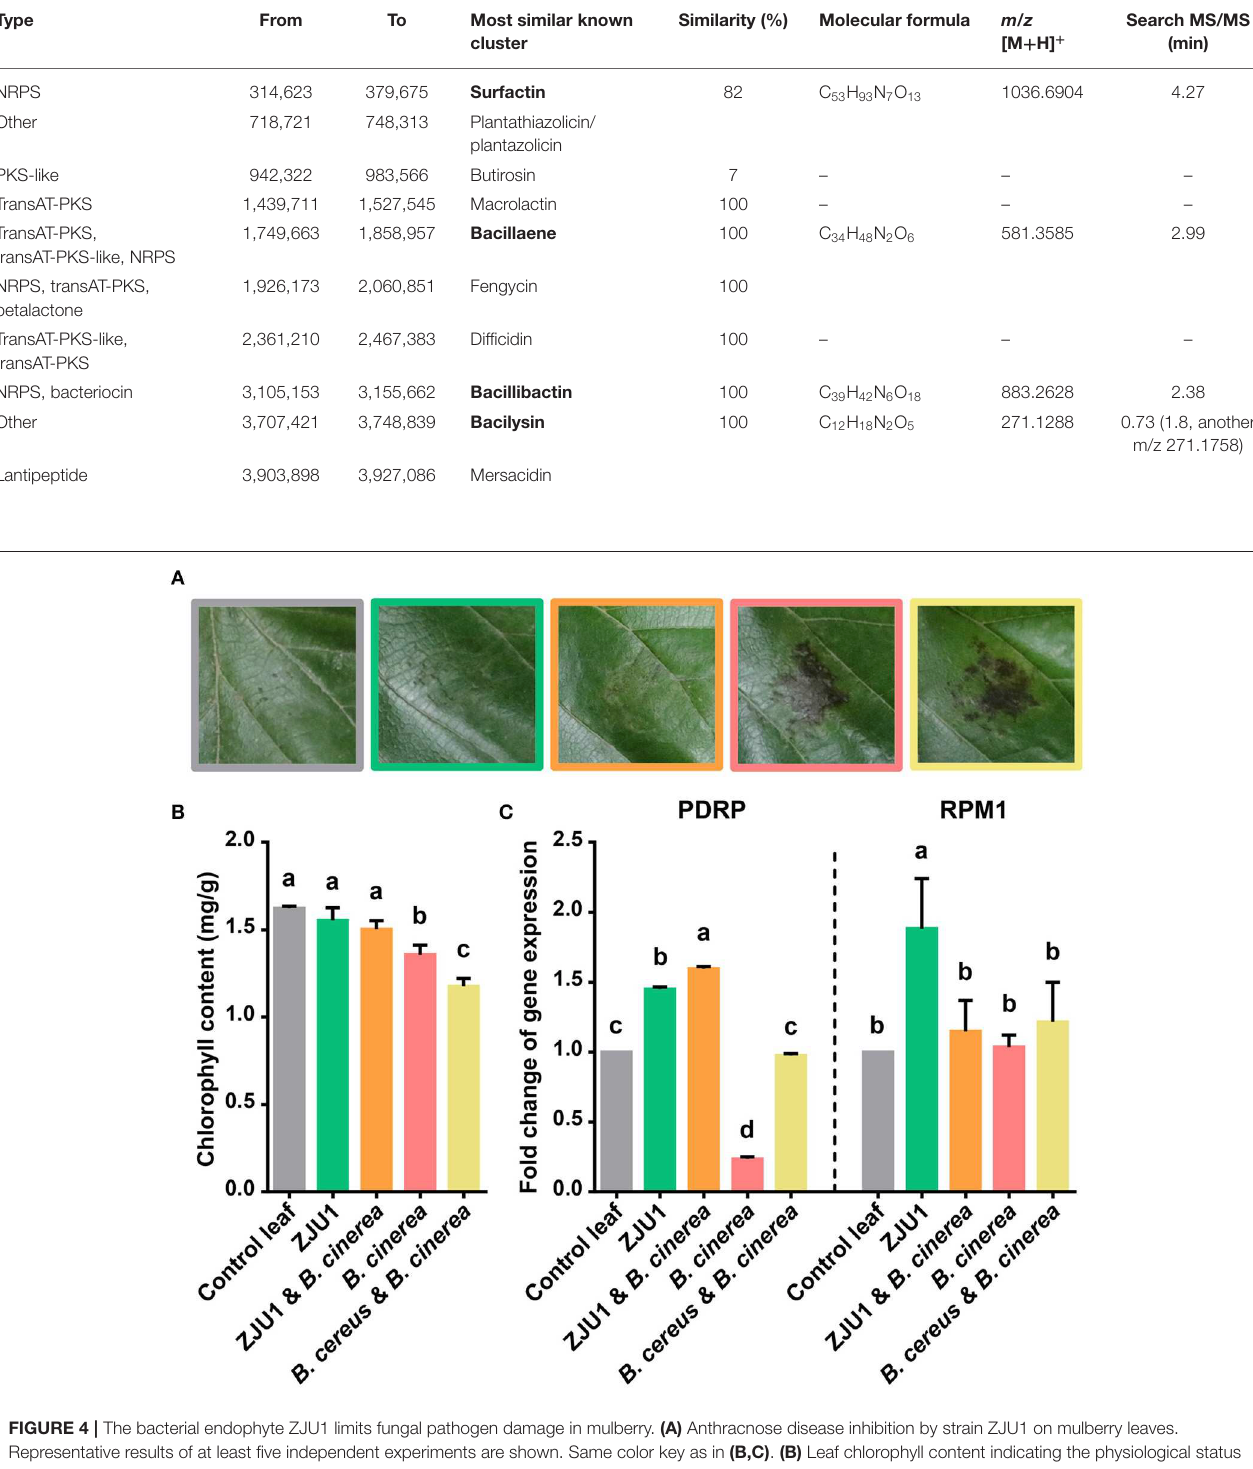
TABLE 1 | Gene clusters directing antimicrobial synthesis in B. amyloliquefaciens ZJU1 and the in situ determination of metabolites.